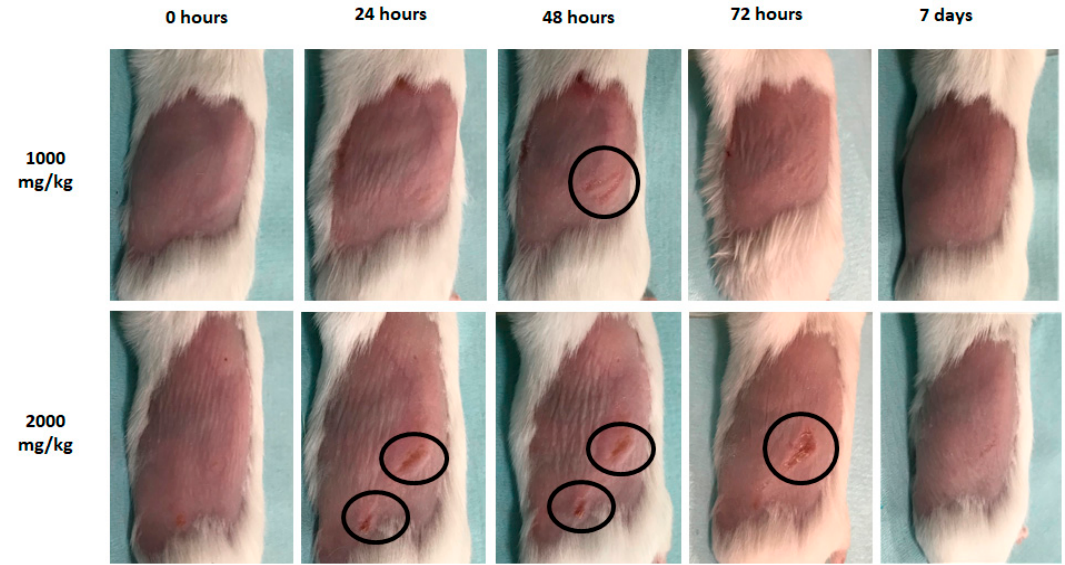
Figure 4. Representative images of mouse skin (of the n number of animals tested) before (t = 0) and at 24, 48, and 72 h and 7 days after dermal application of the test compound.